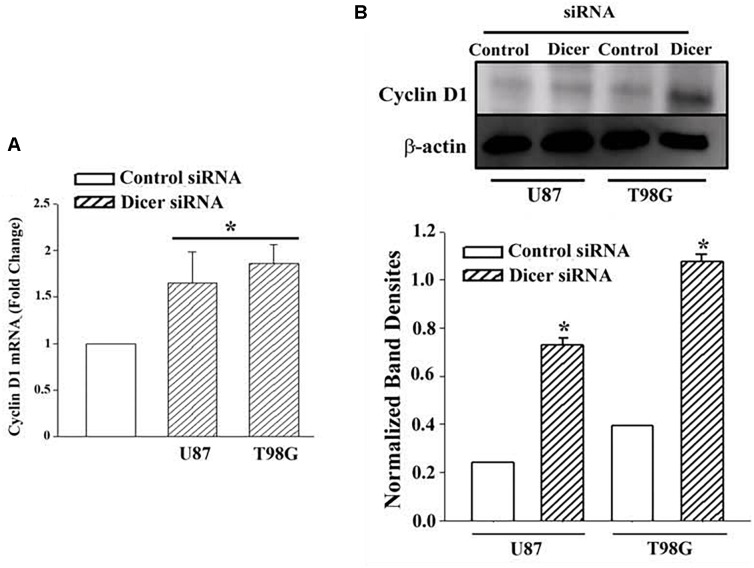
Cyclin D1 in TMZ-resistant, Dicer knockdown GBM cells. U87 and T98G cells were transfected with Dicer siRNA or control siRNA. After this, the cells were treated with 200 μM TMZ for 72 h and then analyzed for Cyclin D1 mRNA by real time PCR (A) and western blot (B). Normalized band densities for three western blots (±SD) are shown in the graph of “A.” ∗p < 0.05 vs. control siRNA.